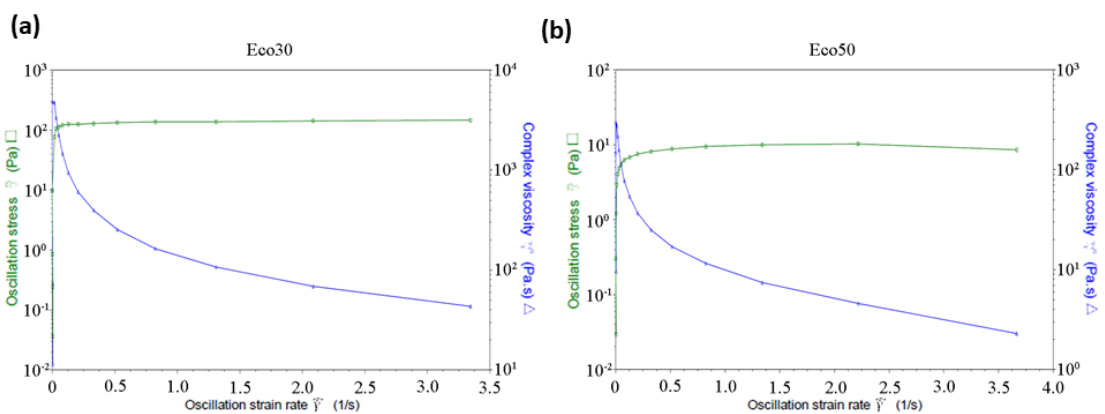
Figure 3. ( a ) Ecoflex30 and ( b ) Ecoflex50 complex viscosity and shear stress versus strain rate.